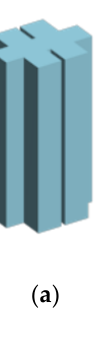
Figure 2. Roof types of ordinary urban buildings: ( a ) flat, ( b ) spire, and ( c ) sloped roofs.